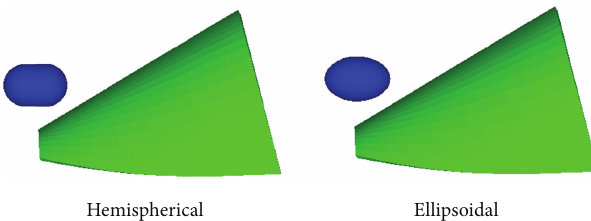
Figure 10: Two different angles of impact on windshield.